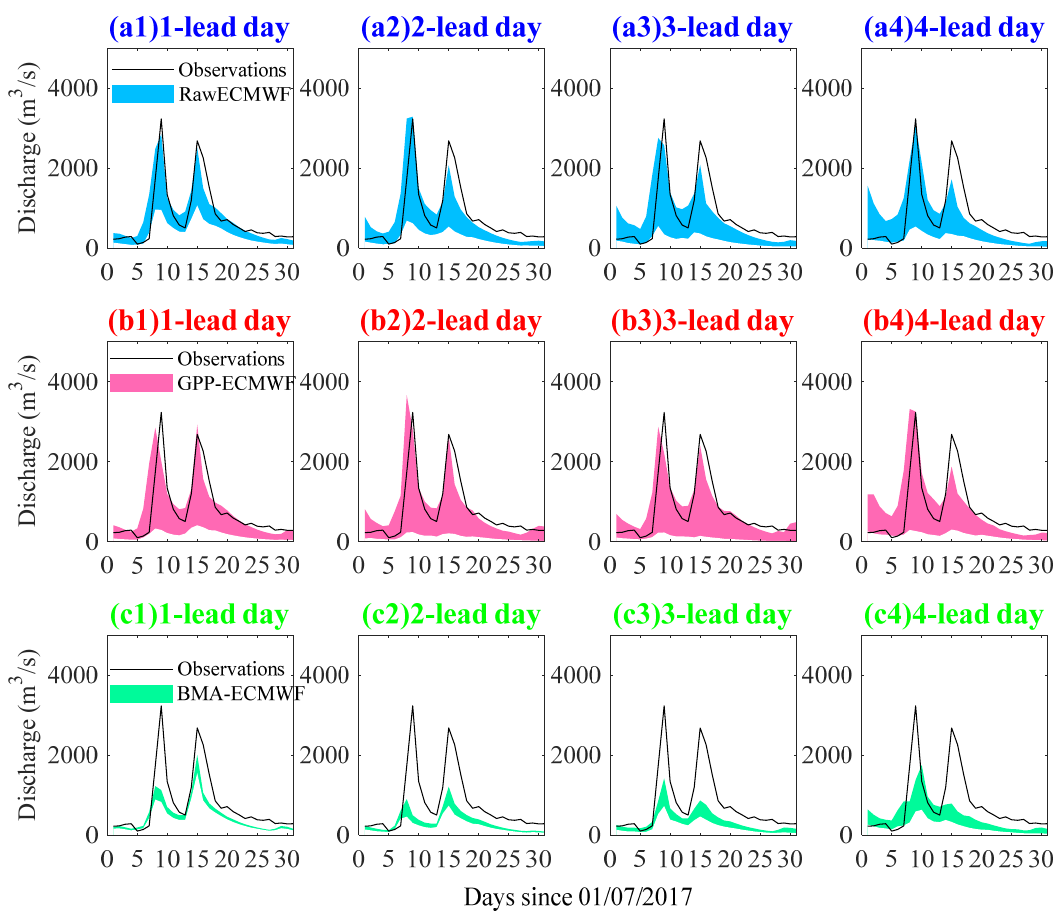
Figure 10. Hydrographs of ensemble streamflow simulated by XAJ model using raw and postpro- cessed EPFs from ECMWF as inputs at 1, 2, 3, and 4 lead days, compared with observed streamflow. The shaded area represents the 5th–95th percentile values driving by 1000 postprocessed ensembles.